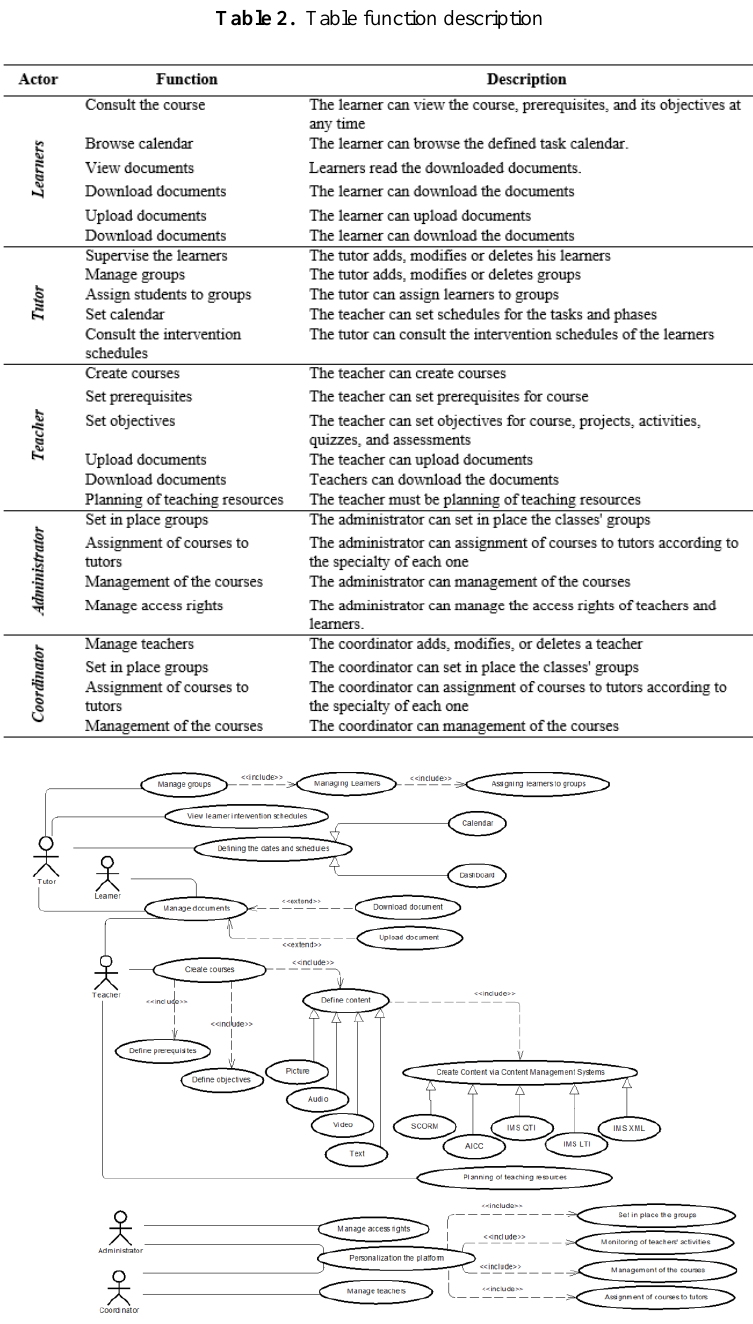
Fig. 1. Use Case Diagram of disciplinary information